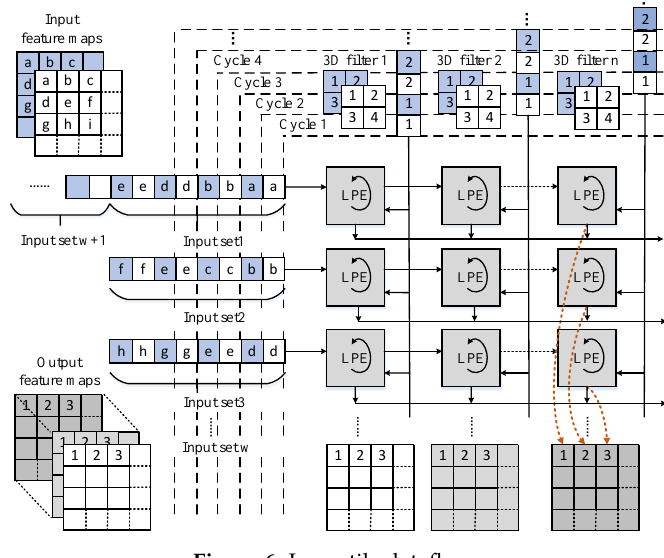
Figure 6. Inner-tile